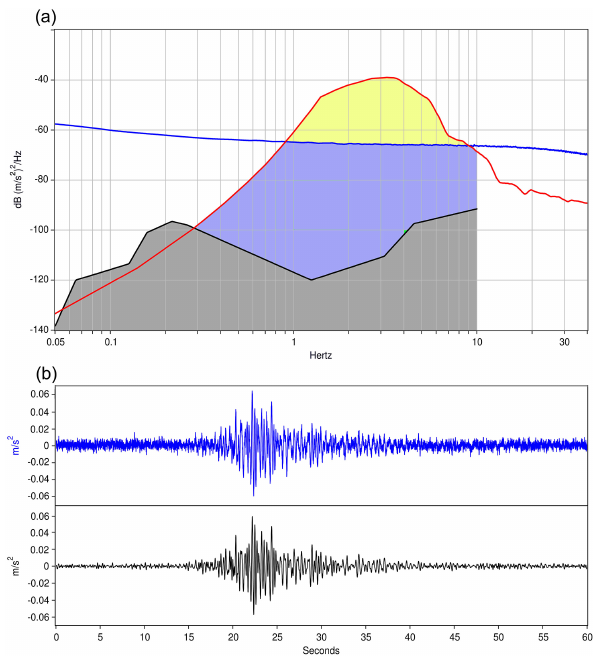
Figure 4. (a) Average PSD of the self-noise produced by the MEMS 1044_0 device accelerometer (blue line) with over plotted the mean horizontal earthquake spectra (red line) of a shallow local seismic event with M L 4 recorded at the epicentral distance of about 35km by the same device. For comparison it is also over plotted the upper Peterson (1993) seismic noise reference PSD (black line); (b) raw NS component waveform of the local event described in (a) as recorded by a MEMS 1044_0 device accelerometer (blue line) and a professional force balance accelerometer (black